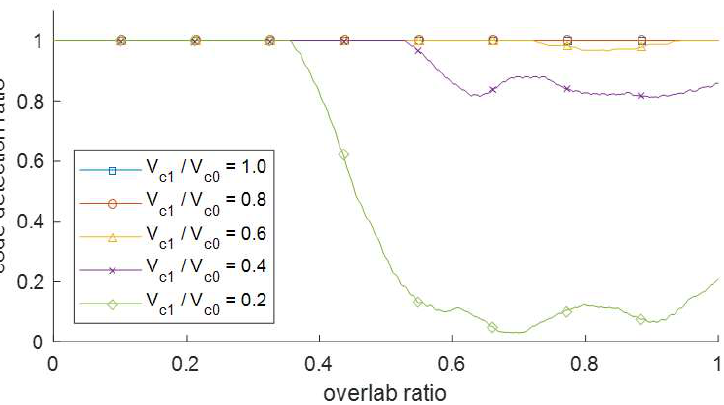
Figure 9. Code detection results of a signal with low signal power when two transmitters transmit with different signal power.